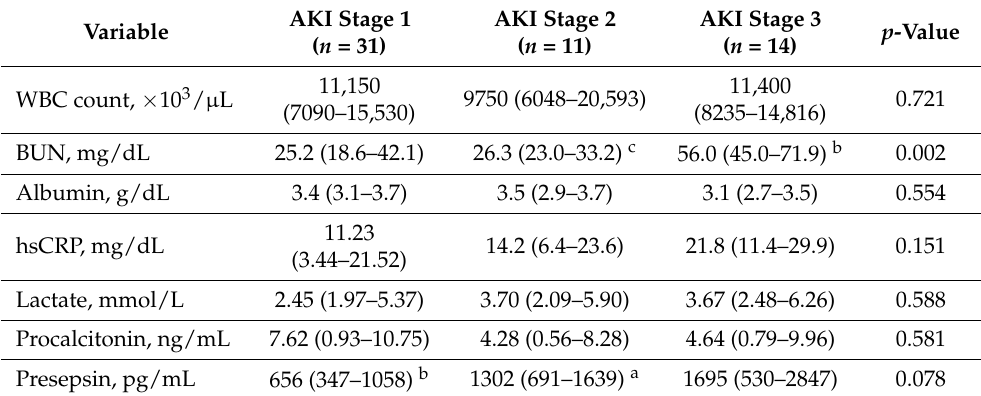
Table 3. Comparison of laboratory results according to AKI